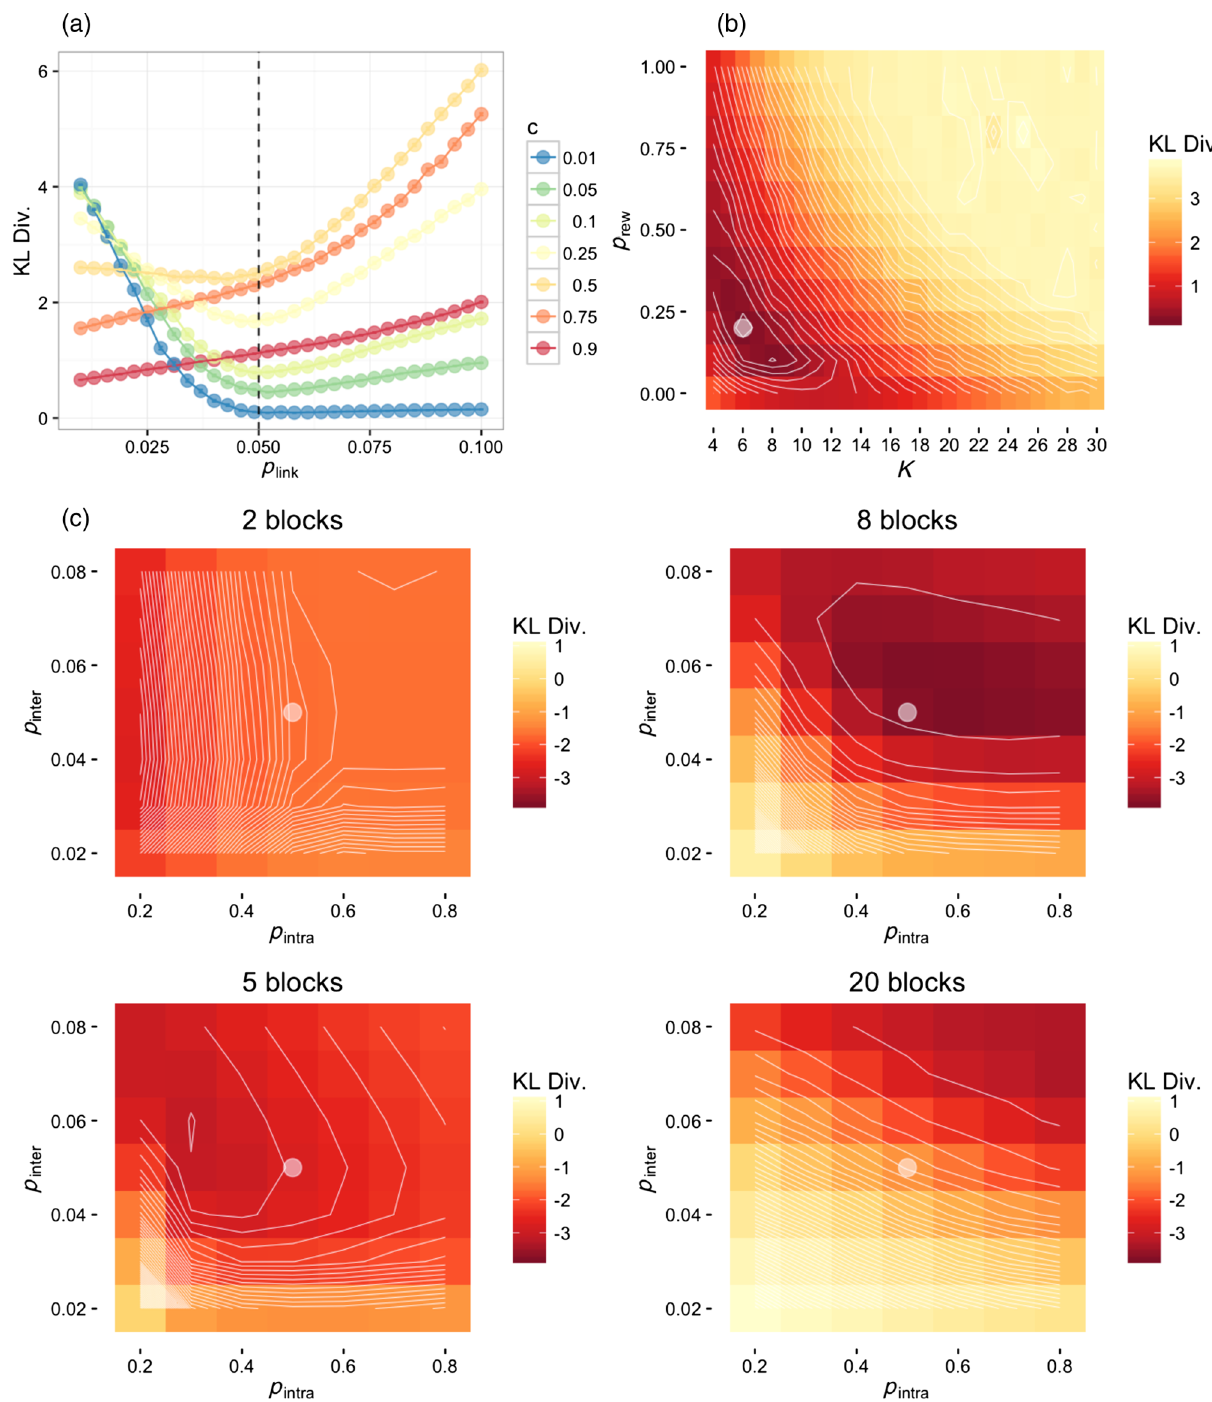
FIG. 5. Maximum-likelihood parameter estimation based on Kullback-Leibler (KL) minimization. (a) Erdös-Rényi network model ( N ¼ 200 ) for different values of the link probability p against an Erdös-Rényi network with p ⋆ ¼ 0 . 05 , assumed to be the data to link link fit. The vertical dashed line indicates the true value of the parameter. Each curve corresponds to a value β ⋆ of β such that S ½ ρ ð β ⋆ Þ(cid:2) = log N ¼ c ð β ⋆ Þ , with c a real number between 0 and 1. Global minima are expected around the true value. (b) Watts-Strogatz ’ s 2 network model ( N ¼ 200 ) for different values of the parameters K and p against a Watts-Strogatz network with K ⋆ ¼ 6 and rew p ⋆ 0 . 2 , assumed to be the data to fit. The white dot indicates the true value and it falls in the iso-likelihood region with smallest rew ¼ Kullback-Leibler divergence (encoded by color in log scale). (c) Stochastic block model ( N ¼ 200 ) for different values of the intra- and intercommunity probability parameters, p and p , and number of equally sized blocks against a network obtained from the same intra inter model with 8 blocks, p ⋆ ¼ 0 . 5 and p ⋆ ¼ 0 . 05 , assumed to be the data to intra inter